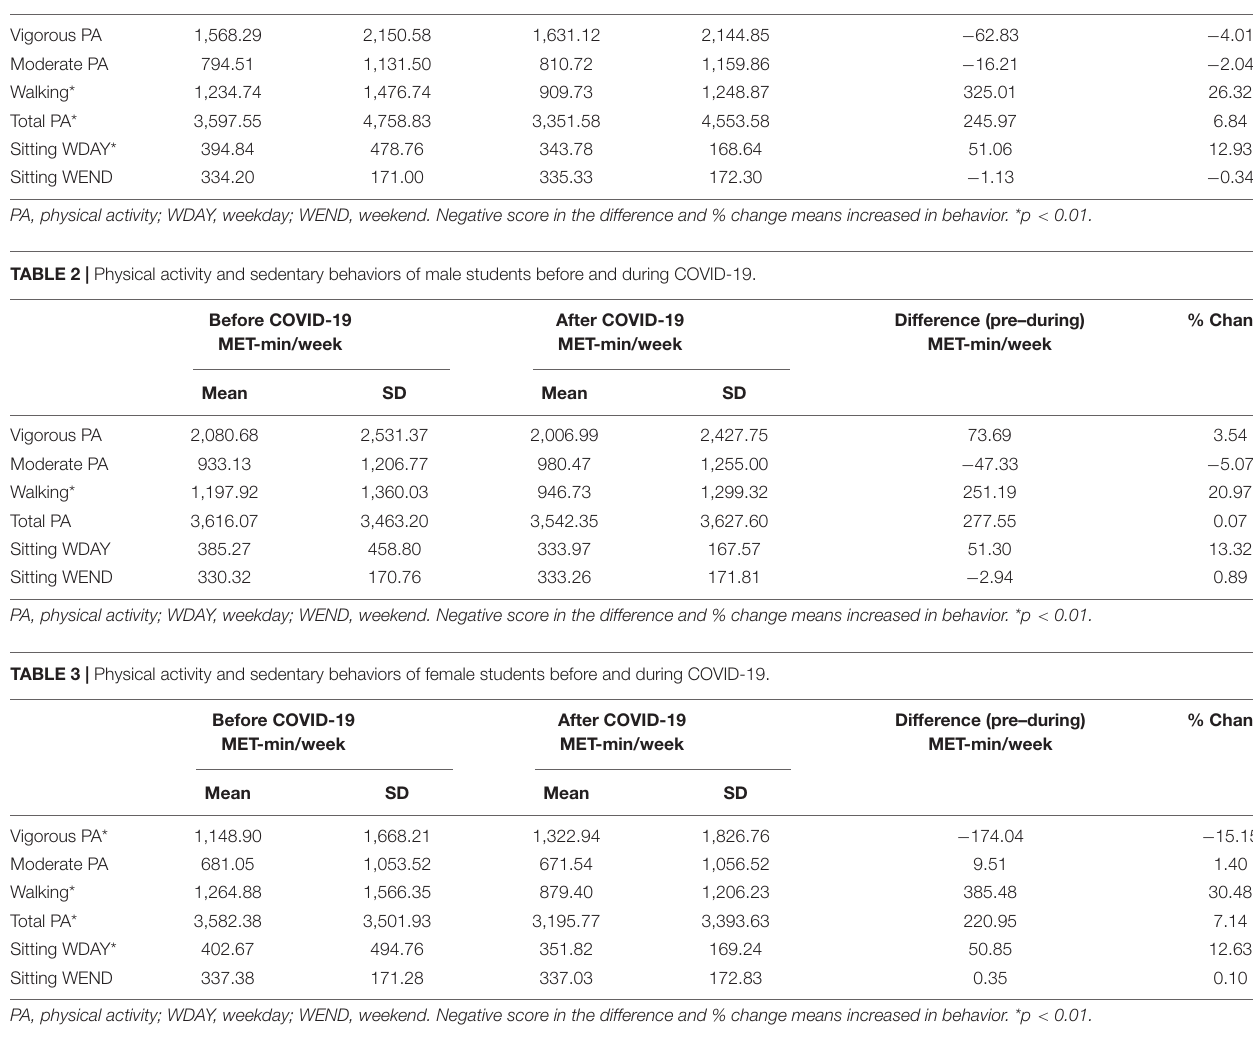
TABLE 1 | Physical activity and sedentary behaviors of students before and during COVID-19 (total sample). Before COVID-19 MET-min/week